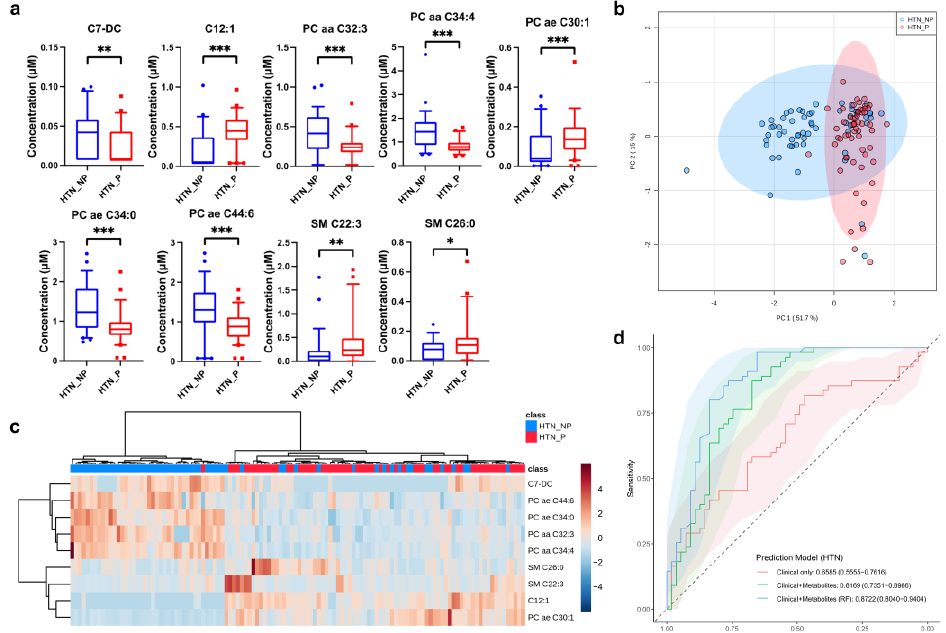
Figure 3. Multivariate statistical analysis and predictive modeling of the selected HTN progression-